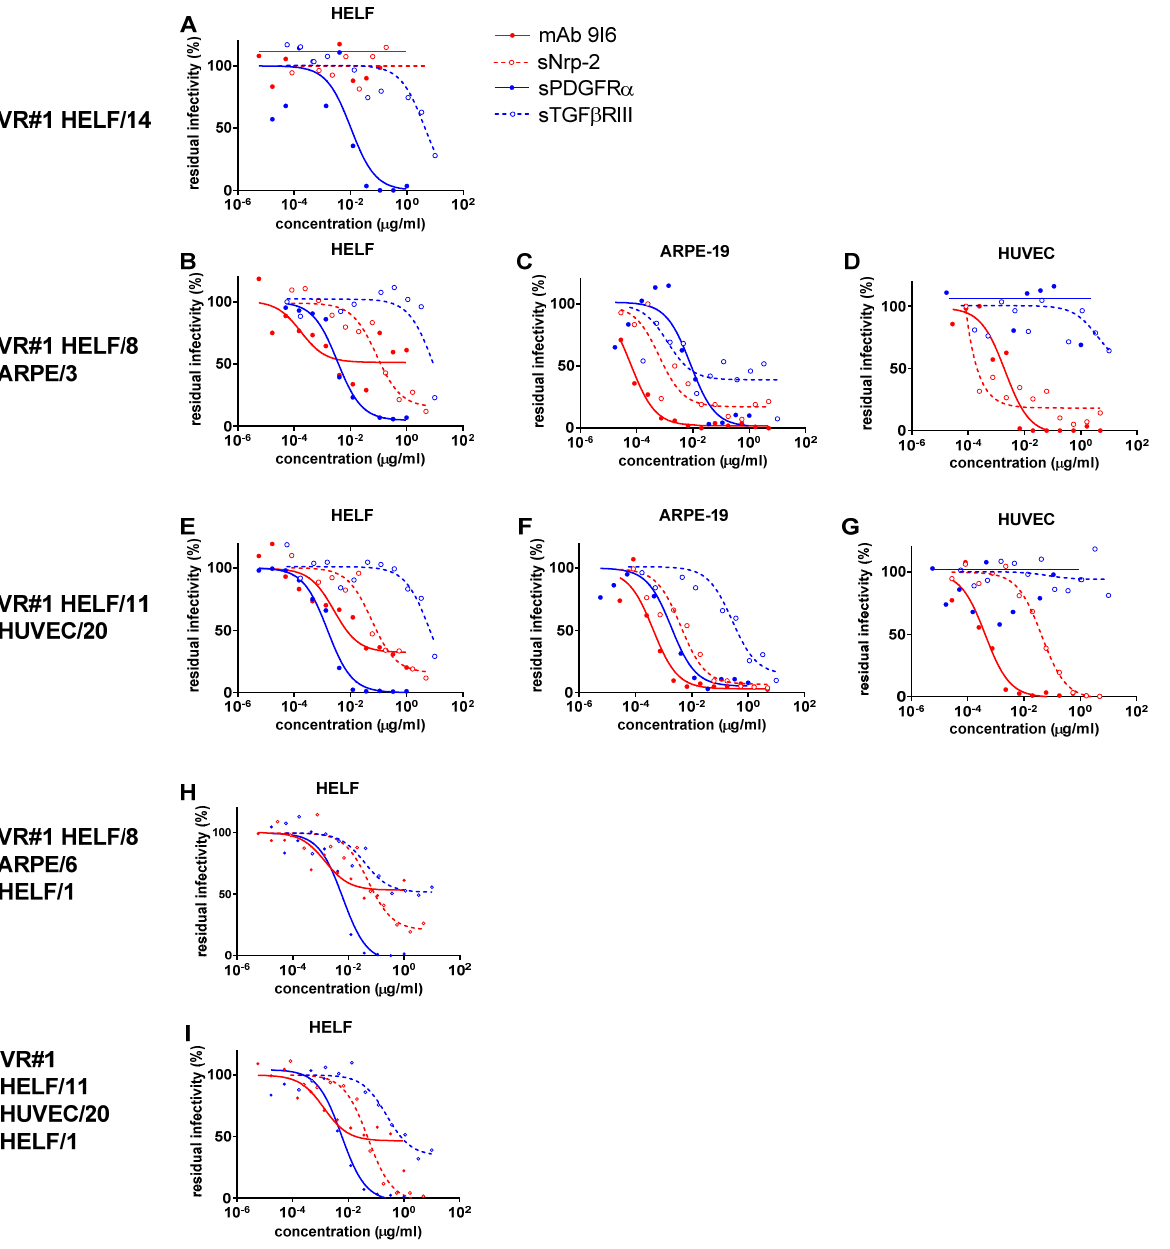
Figure 1. ICs 50 of anti-PC (mAb 9I6, and sNrp-2) and anti-TC (sPDGFR- α , and sTGF β RIII) activity in inhibiting infectivity of VR#1, which was recovered and propagated in HELF/14 ( A ), then passaged in ARPE-19/3 ( B – D ) cells, and finally, in HUVEC/20 ( E – G ) primary cells, as determined in HELF ( A , B , E ), ARPE-19 ( C , F ) and HUVEC ( D , G ) cell substrates against residual infectivity. The inhibiting activities of VR#1 infectivity by different agents following back passages of VR#1 from ARPE/16 and HUVEC/20 onto HELF/1 are shown in ( H , I ), respectively.